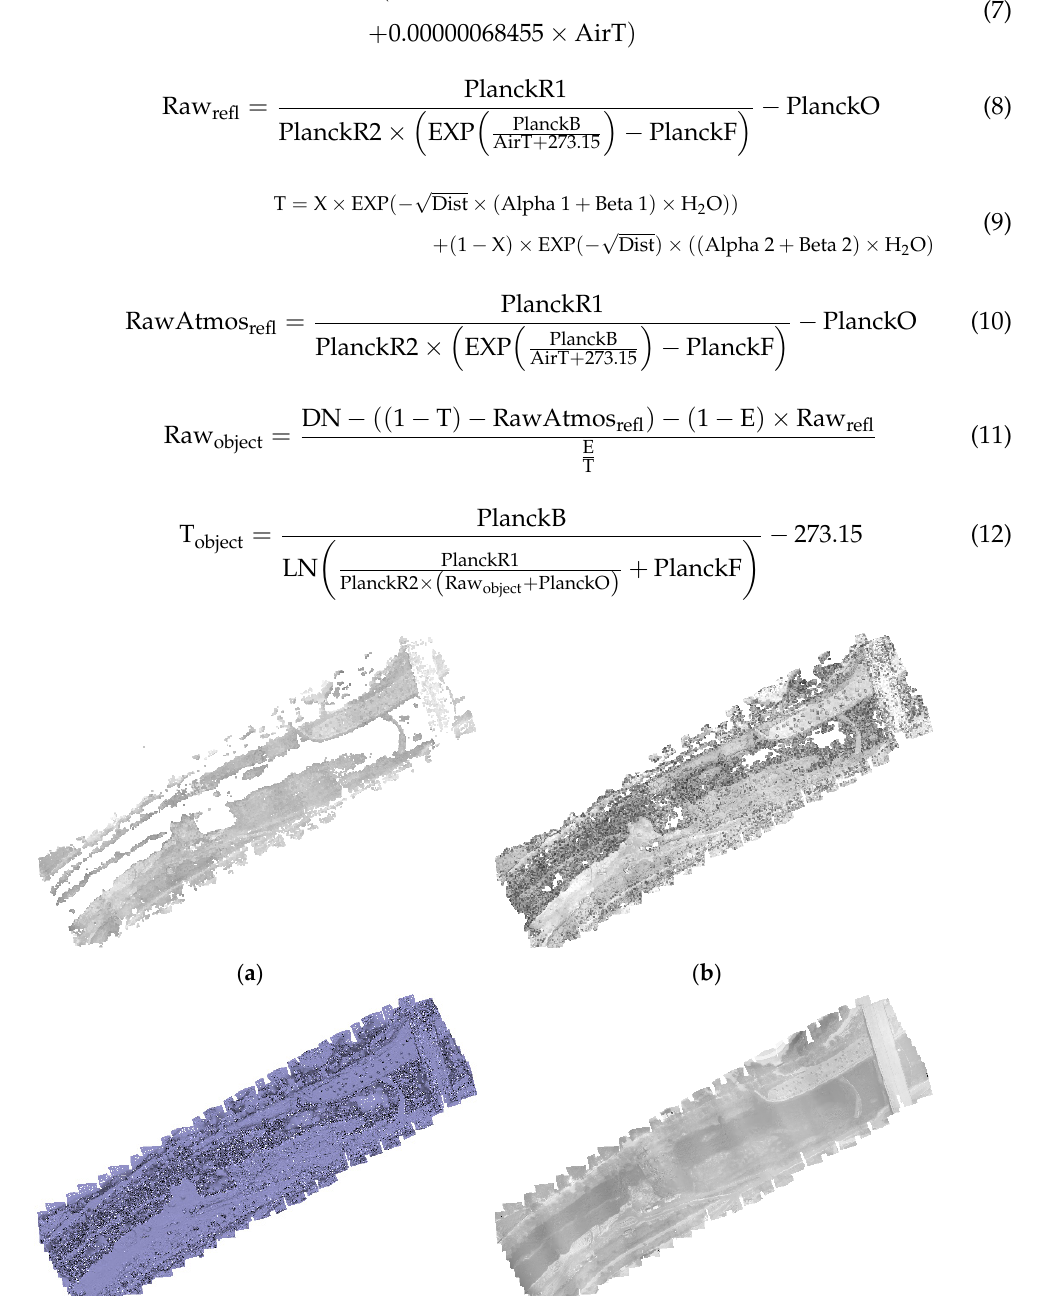
each parameter for Equations (7)–(12) differs depending on the type of TIR camera and the external environment at the time of shooting [30].